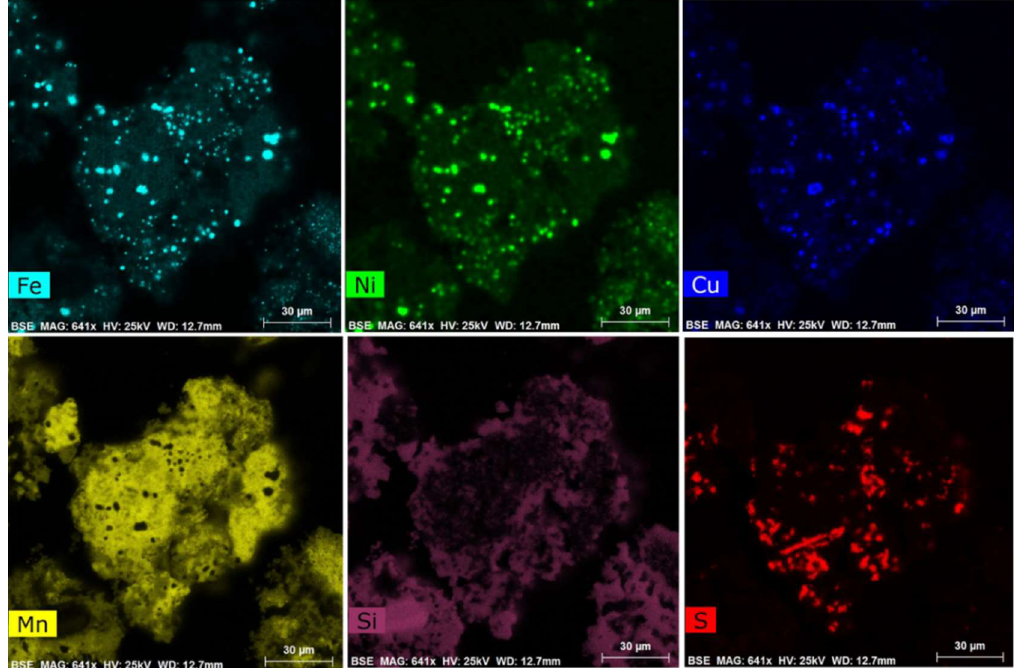
Figure 5. Element maps of a transformed nodule fragment of sample P3 (see BSE image in Figure 4A).